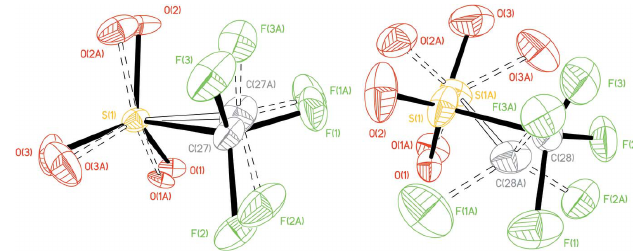
Figure 2 Ball and stick rendering of the trifluoromethanesulfonate ion for 1 at